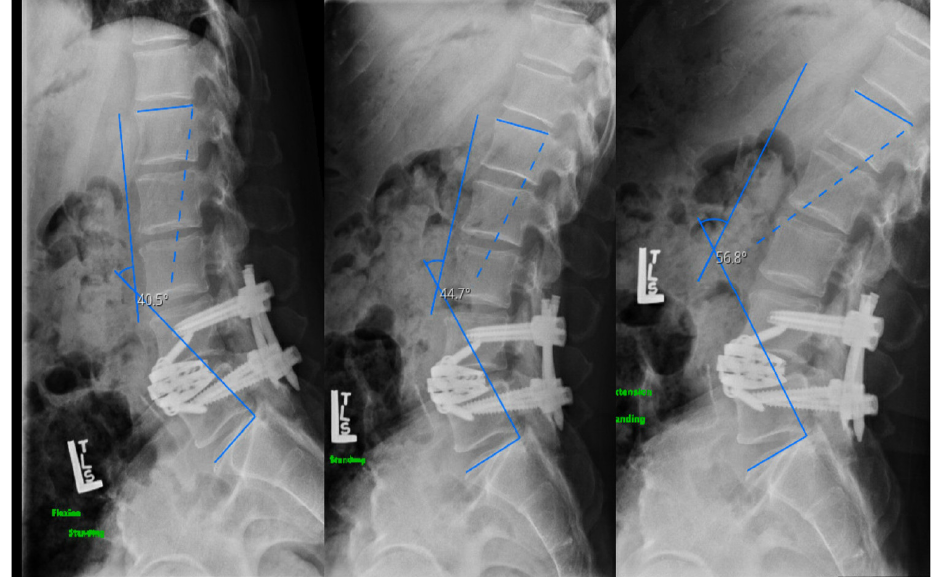
Figure 8. Effect of posture on lumbar lordosis in case III. Flexion-extension lumbar X-ray at 16-months post-operative showing more than 16 degrees of difference in lumbar lordosis between flexion and extension. Lumbar lordosis-pelvic incidence mismatch normalized with lumbar extension.